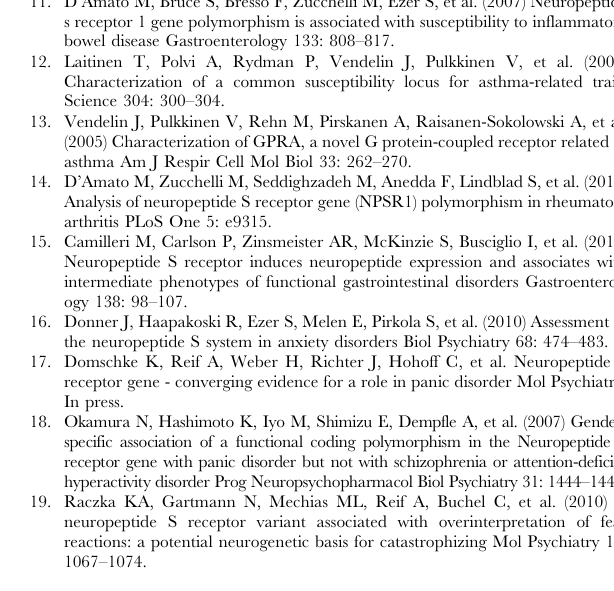
Figure S1 Characterization of NPSR1 predicted pro- moter. Left: ARTS-predicted NPSR1 promoter sequence, spanning nucleotides -595 to + 1 from the translational start site (ATG). Transcription factors (TFs) predicted to bind to the promoter from MatInspector analysis are also reported, with their recognitions sites underlined. Among these, TFs involved in the modulation of inflammatory responses are shown in blue, while TFs known to regulate neurological functions are shown in green. Four common (MAF . 0.02) SNPs mapping within the predicted promoter region are reported in red, together with the corresponding alleles at each site. Right: assessment of the functional activity of NPSR1 predicted promoter in luciferase reporter assays. Colo205 cells were transiently transfected with either a promoterless luciferase vector (pGL3-basic) or the same vector carrying NPSR1 promoter driving luciferase transcription (pNPSR1P). Results, which are representative of 3 independent experiments performed in duplicate, are expressed as fold induction, relative to the luciferase activity obtained for the control transfection (empty vector). Figure S2 Gene Ontology (GO) analysis of genes differentially expressed upon NPS/NPSR1 signaling. Biological process annotations of the hits identified through microarray analysis of NPS-induced changes in gene expression, in HEK293 cells transiently transfected with NPSR1 expression plasmid vs cells transfected with empty vector. Figure S3 Characteristics of NPSR1 coding polymor- phisms. Left: alignment of NPSR1 coding SNPs 107 (rs324981), 197 (rs34705969), 241 (rs727162) and 344 (rs6972158) in different species. Only residue 344 shows some variability, while residues 107, 197 and 241 are conserved across all species. Right: